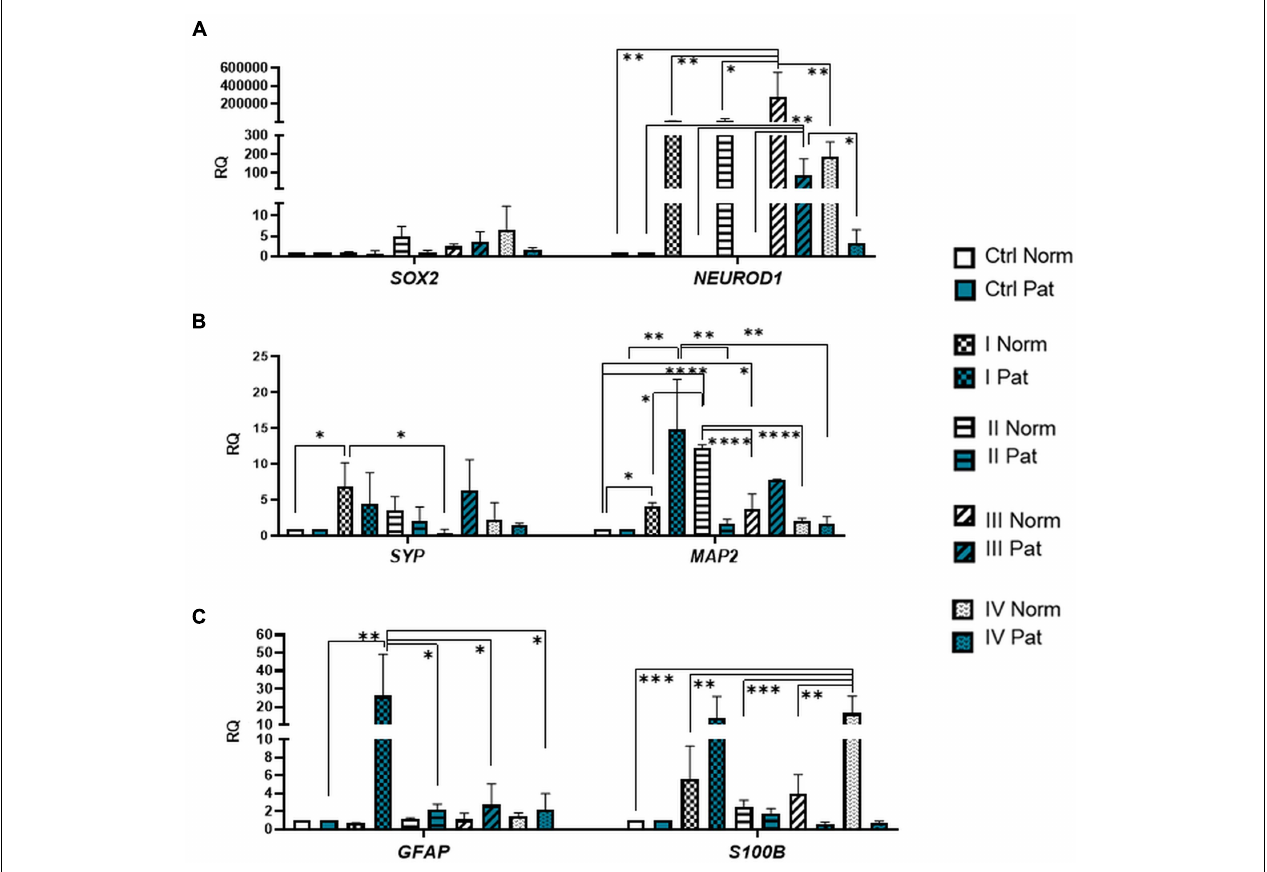
FIGURE 6 | Gene expression profile of neuronal transcription factors and post-mitotic neuronal and glial markers in hAFSCs from normal and fetus–affected gestations induced to neuronal differentiation. RT-qPCR analysis of (A) hAFSCs neuronal transcription factors SOX2 and NEUROD1 , (B) markers of differentiated post-mitotic neural cells SYP and MAP2 , and (C) glial markers GFAP and S100B . Gene expression analysis was performed using control hAFSCs (not treated, Ctrl) and neuronal differentiation-induced hAFSCs (treated for 72 h with I–IV differentiation protocols; see Table 1 in section “Materials and Methods”) from normal (Norm, n = 3) and fetus-pathological (Pat, n = 3) gestations. RT-qPCR data are represented as relative fold change over undifferentiated control, normalized for the housekeeping genes GAPDH and RPL13A ; values are indicated as mean ± SD. *Denotes significant difference with p < 0.05, **denotes significant difference with p < 0.01, ***denotes significant difference with p < 0.005, and ****denotes significant difference with p < 0.0001, as evaluated using one-way ANOVA with Tukey’s post hoc